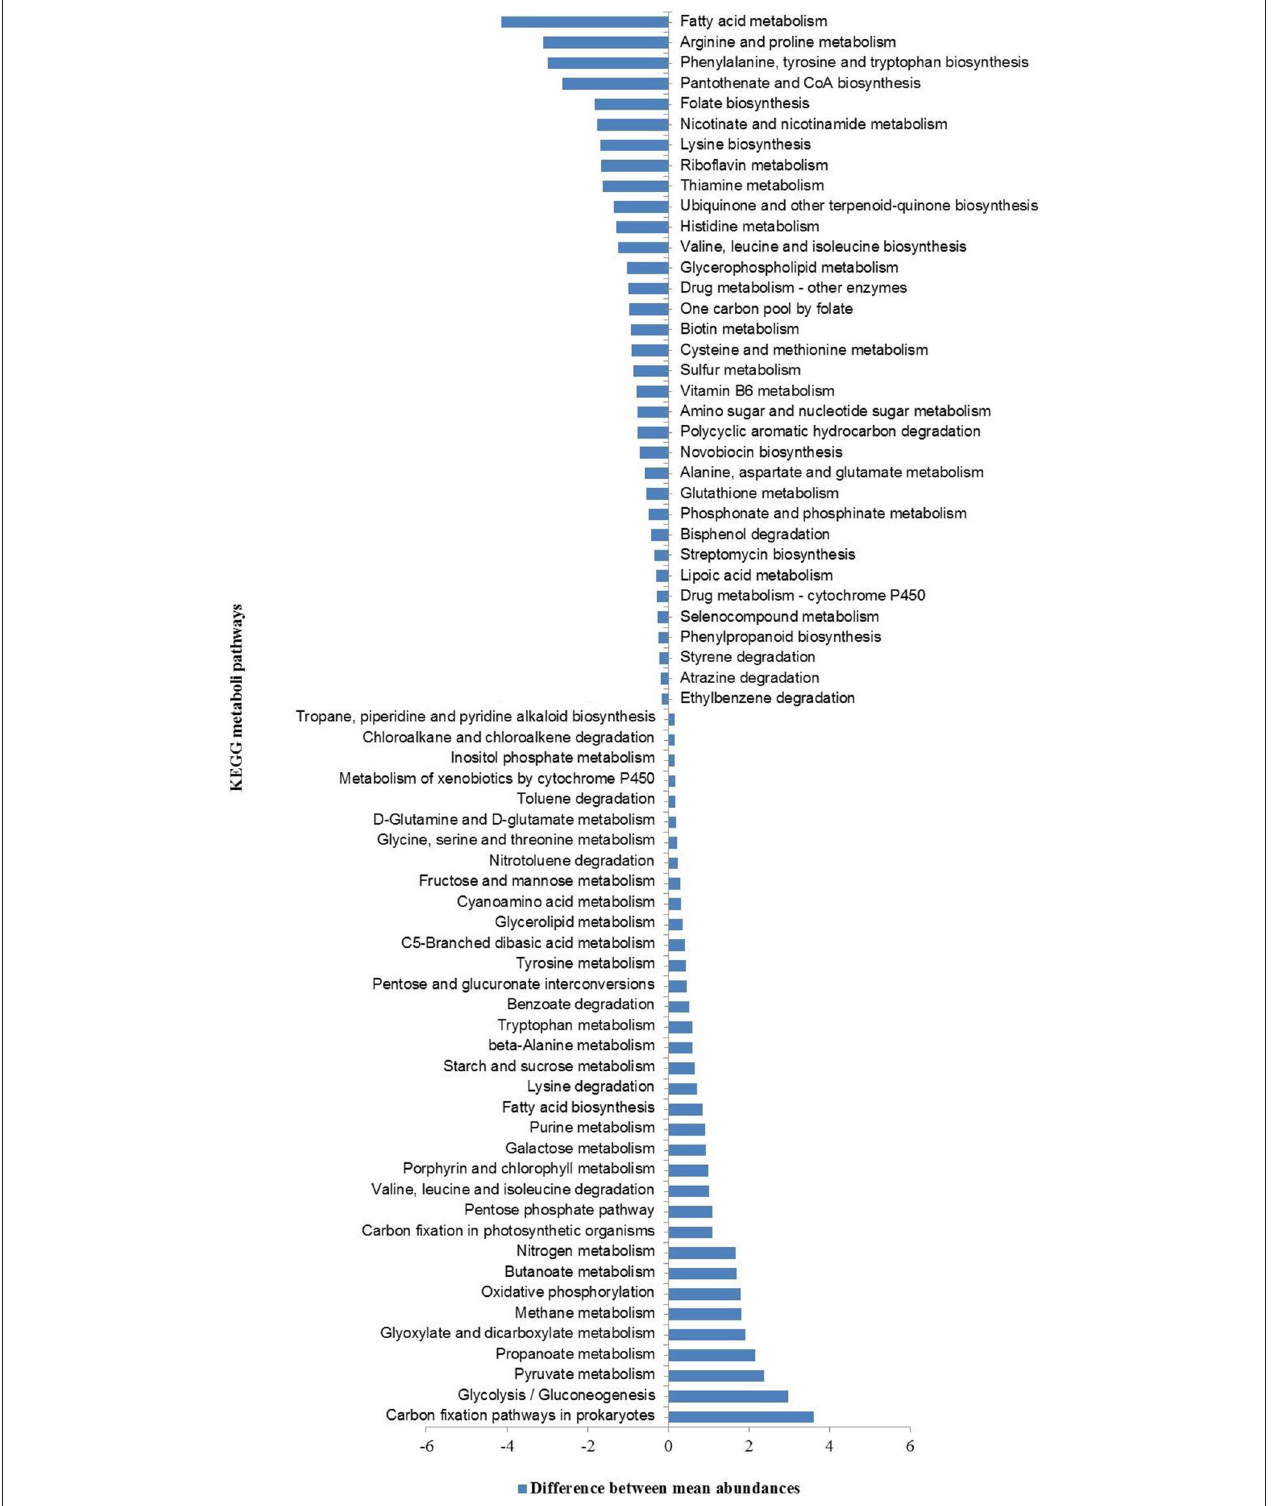
FIGURE 6 | KEGG pathways over- and under-represented in hot spring metagenomes relative to all sequenced bacterial and archaeal genomes (NCBI-RefSeq database).